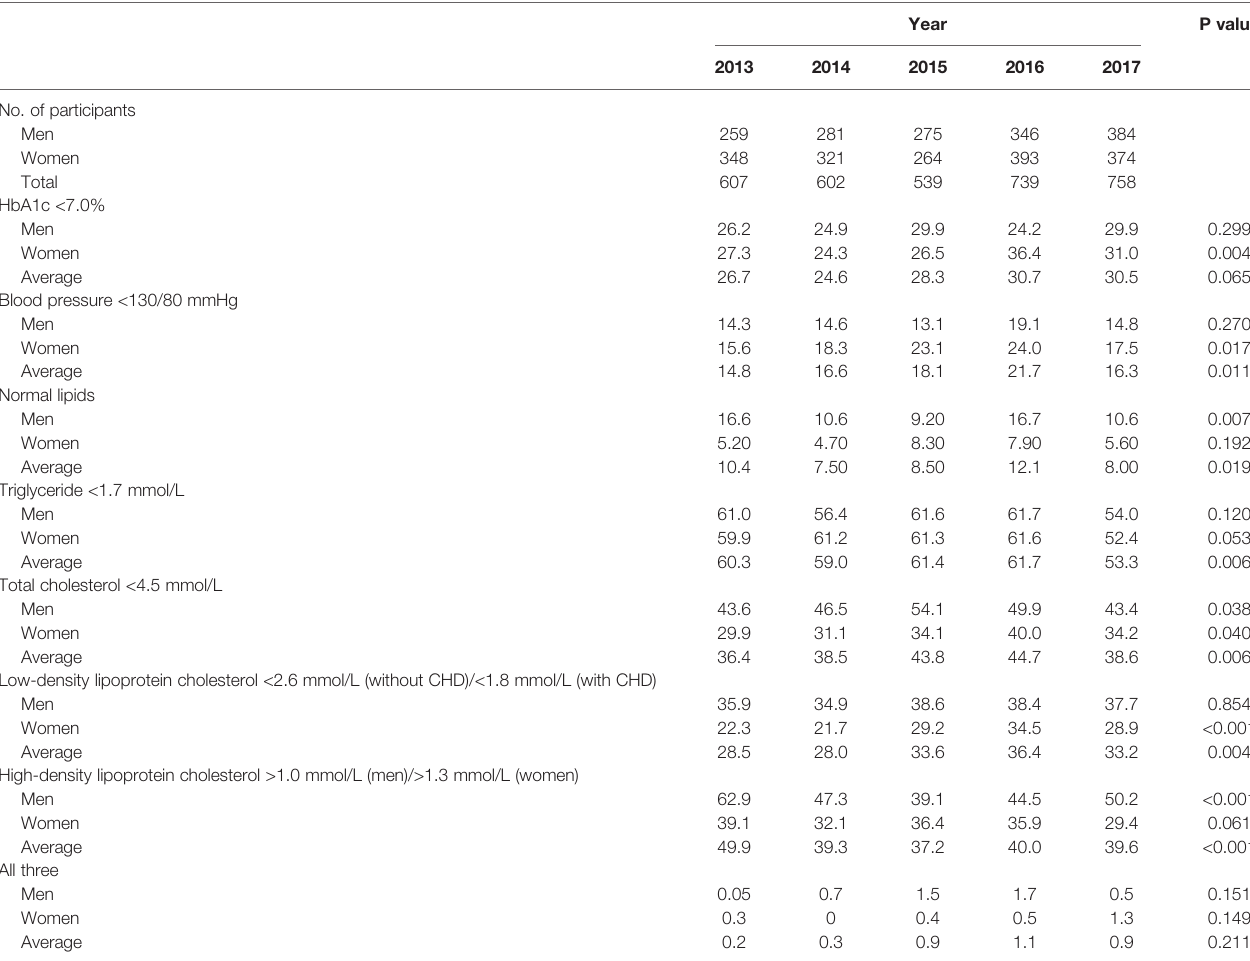
TABLE 2 | Percentage of inpatients with type 2 diabetes attaining the Chinese Diabetes Society goals for Prevention and Treatment of Diabetes from 2013 to